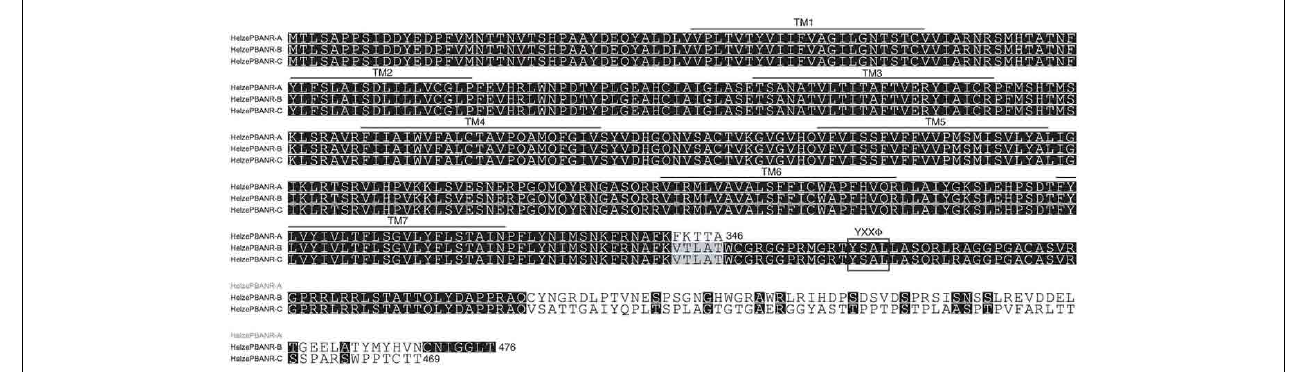
v6.814b (Katoh et al., 2002) with certain gaps removed. Species abbreviations are per National Center for Biotechnology Information/Swiss Prot: Helze, Helicoverpa zea .